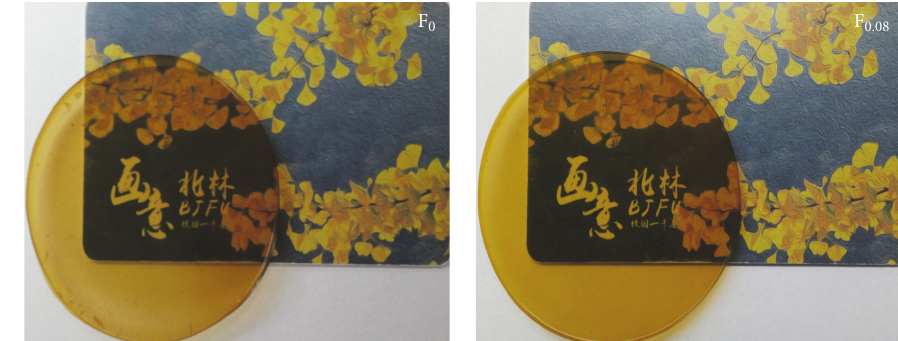
Figure 2: The photos of composite films F 0 and F 0.08 .